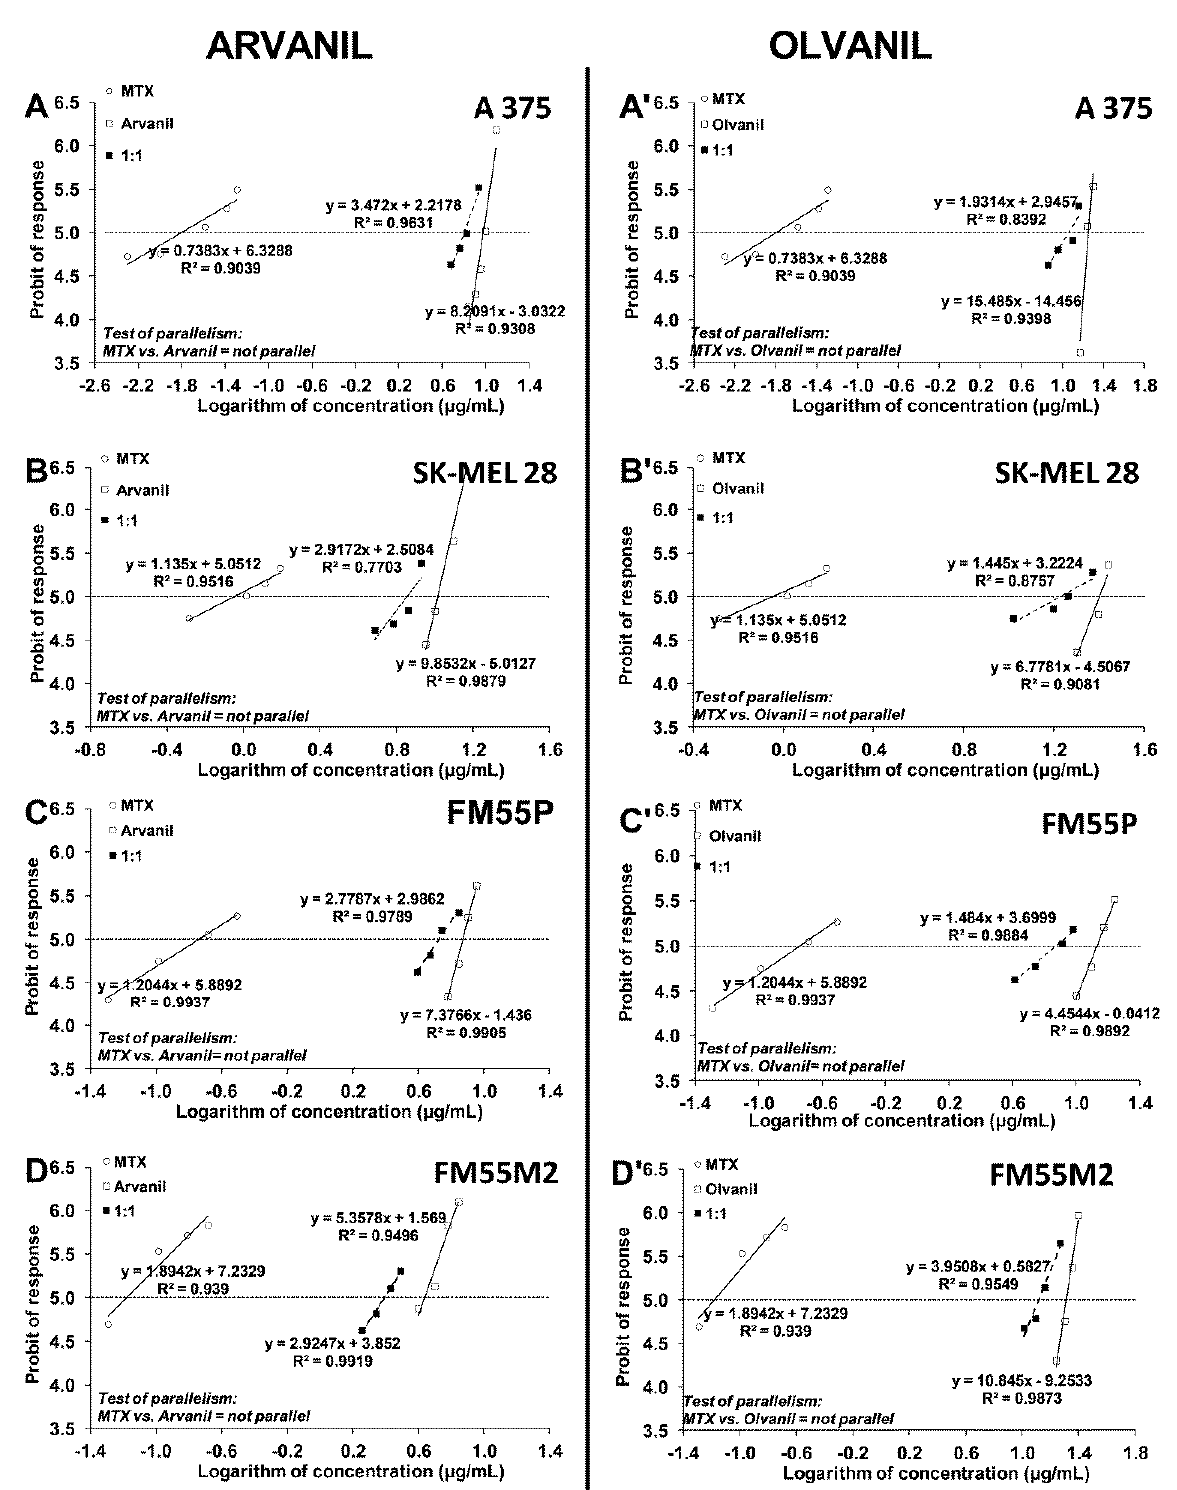
Figure 9. Concentration–effect lines for arvanil, olvanil, and MTX administered alone and in combination in the fixed-ratio of 1:1, illustrating the anti-proliferative effects of the drugs in the malignant melanoma cell lines: A375 ( A , A’ ), SK–MEL 28 ( B , B’ ), FM55P ( C , C’ ), and FM55M2 ( D , D’ ) measured in vitro by the MTT assay. Test for parallelism confirmed that the experimentally determined concentration–effect lines for arvanil, olvanil, and MTX (administered alone) are mutually non-parallel to each other in A375, SK–MEL 28, FM55P, and FM55M2 cell lines. Isobolographic analysis of interactions for non ‐ parallel concentration ‐ response lines revealed that the combination of arvanil with CDDP at the fixed ratio of 1:1 exerted an ‐ tagonistic interactions in the A375 melanoma cell line (Figure 10A). The IC 50mix value for this combination significantly differed from the upper IC 50add value (Student’s t ‐ test with